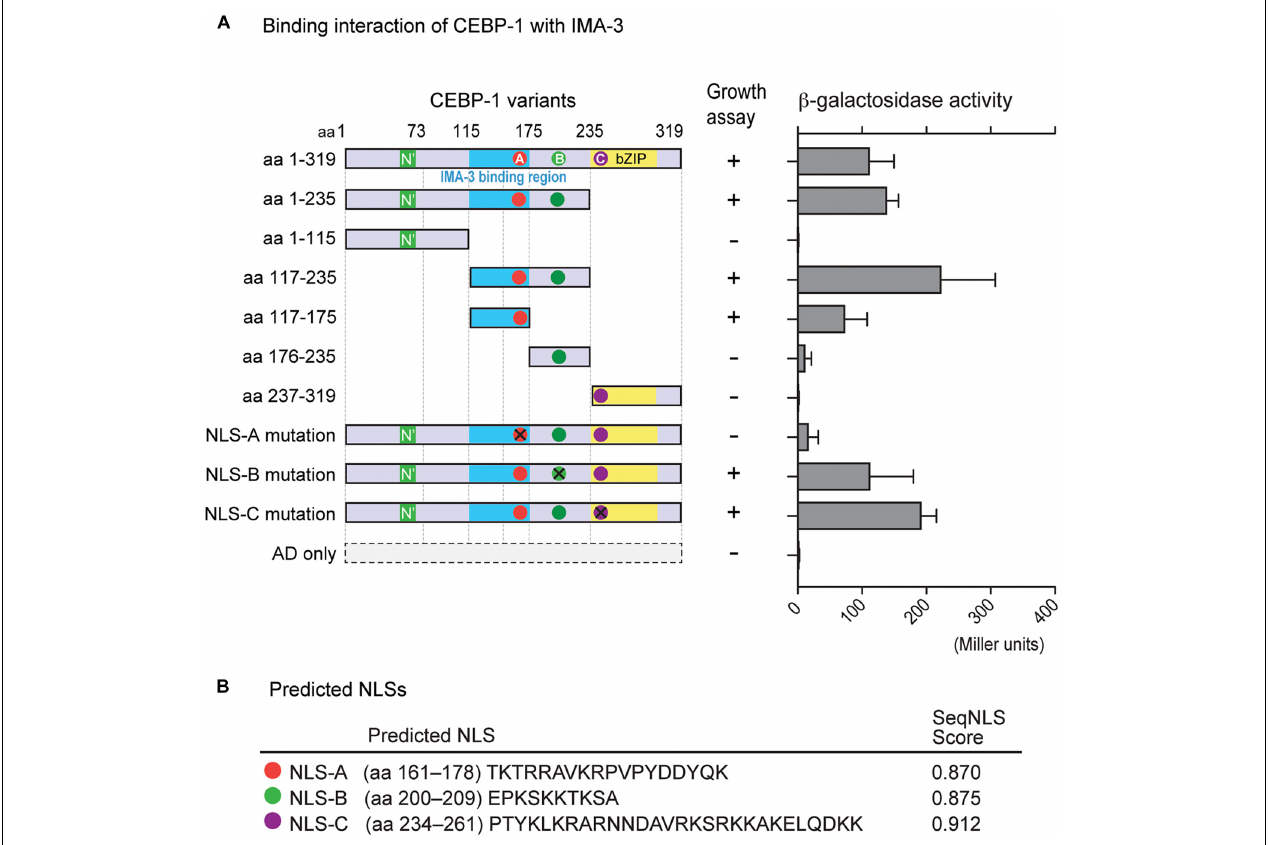
FIGURE 3 | CEBP-1 interacts with IMA-3. (A) Delineation of the minimal CEBP region required for interaction with IMA-3. The indicated AD-CEBP-1 fragments and NLS mutants were tested for interaction with BD-IMA-3(aa 278–514), except the interaction test between BD-CEBP-1(aa 237–319) and AD-IMA-3(aa 1–514). (B) Nuclear localization signals (NLSs) of CEBP-1 predicted using the seqNLS program.